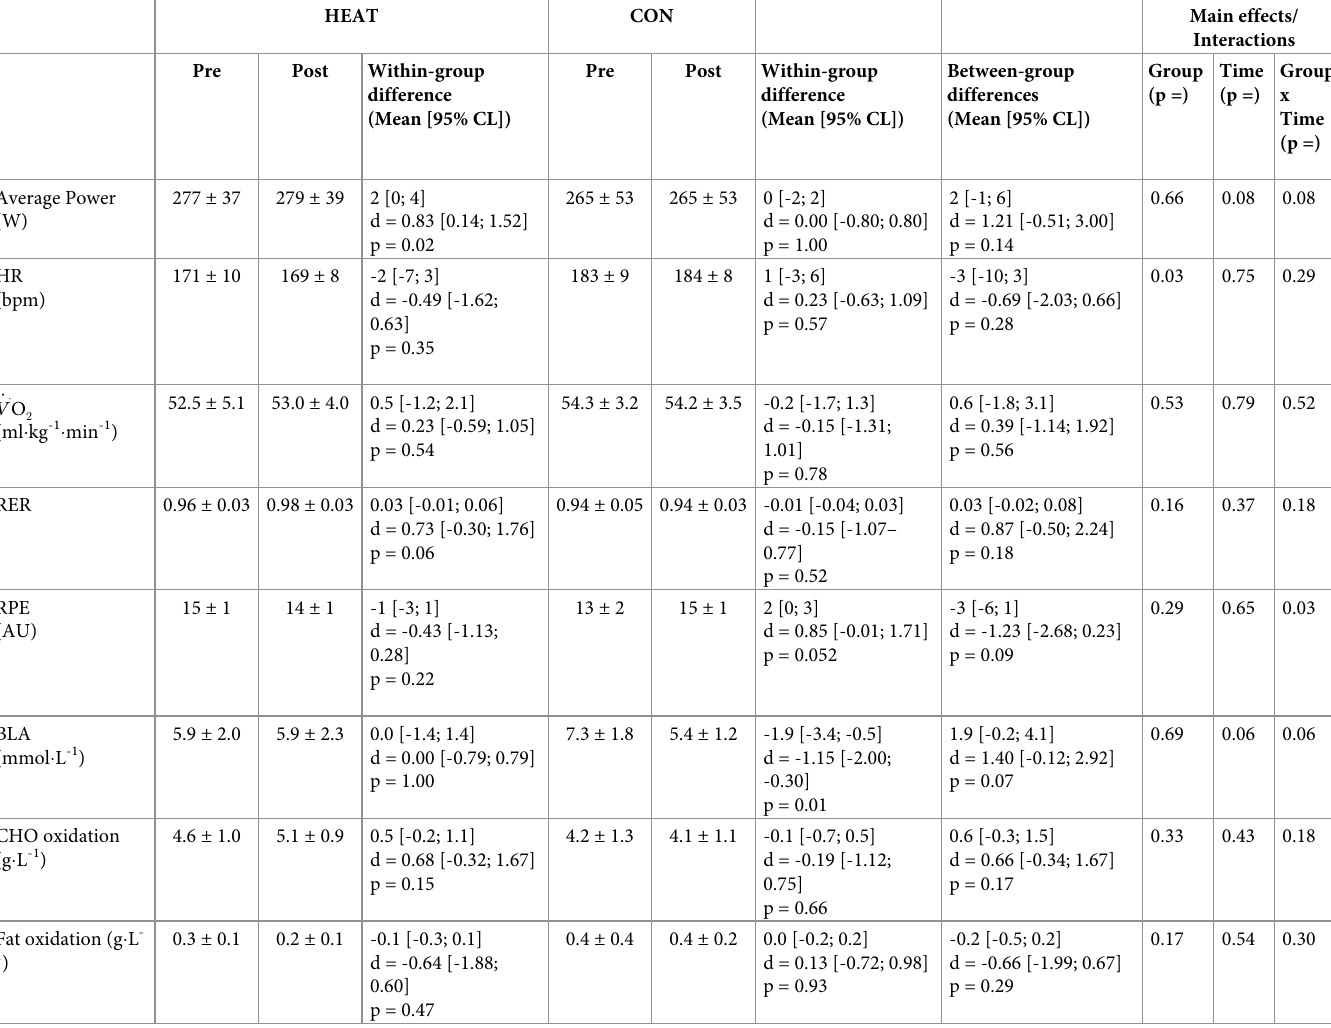
Table 2. Comparison of physiological and perceptual measures of national-level rowing athletes taken during a 10-min submaximal rowing test performed at 95% of 30-min time-trial average power output, before (Pre) and after (Post) a 10-session heat acclimation intervention. CON Main effects/